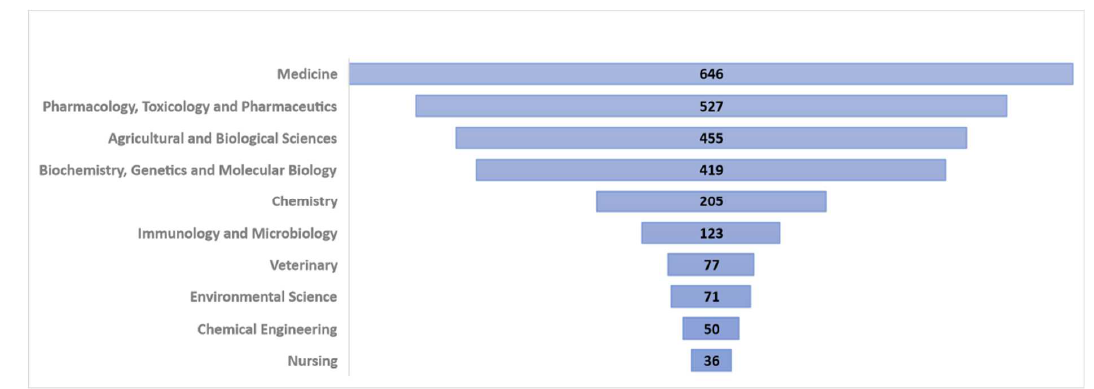
Figure 2. Publications by scientific categories indexed in Scopus [9].